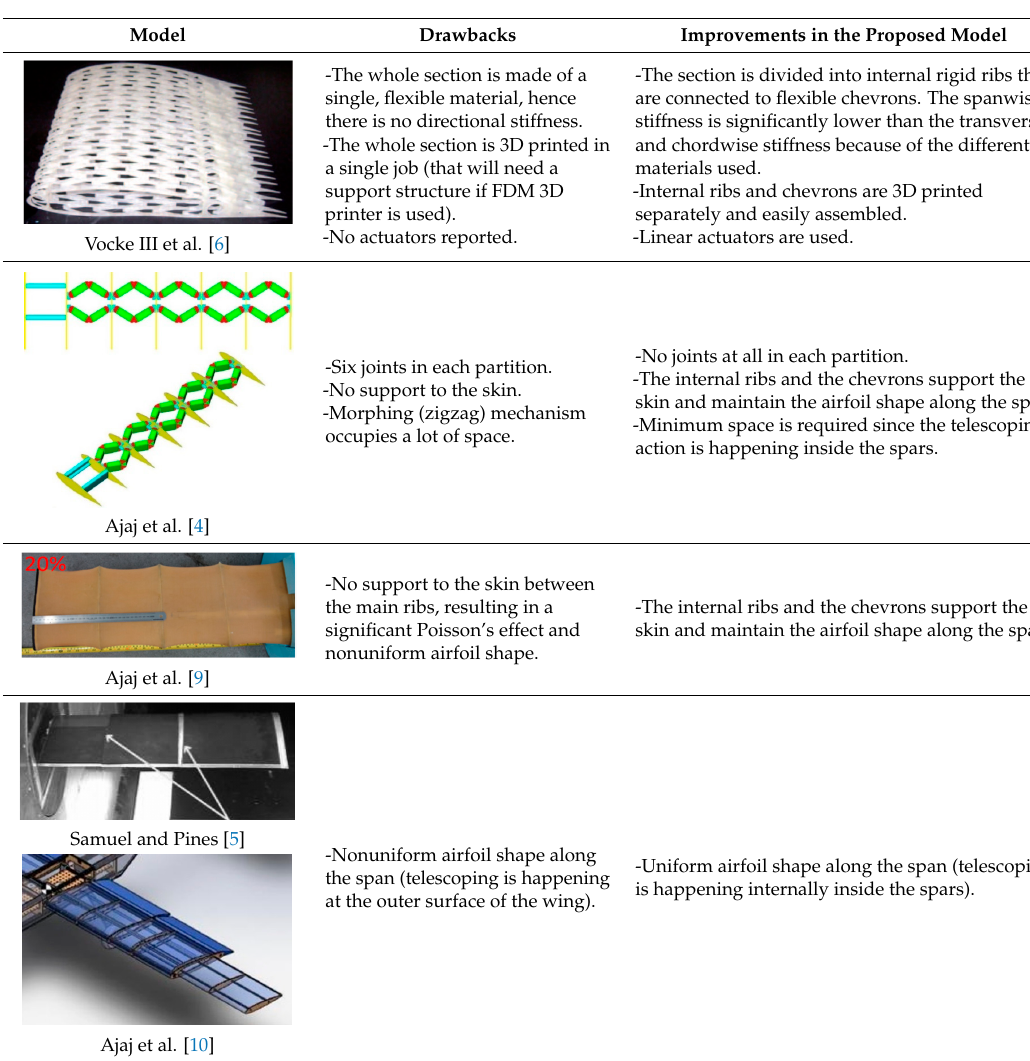
Table A1. Drawbacks of previous span-morphing wing designs, based on the authors’ opinion, and the improvements made in the proposed design.